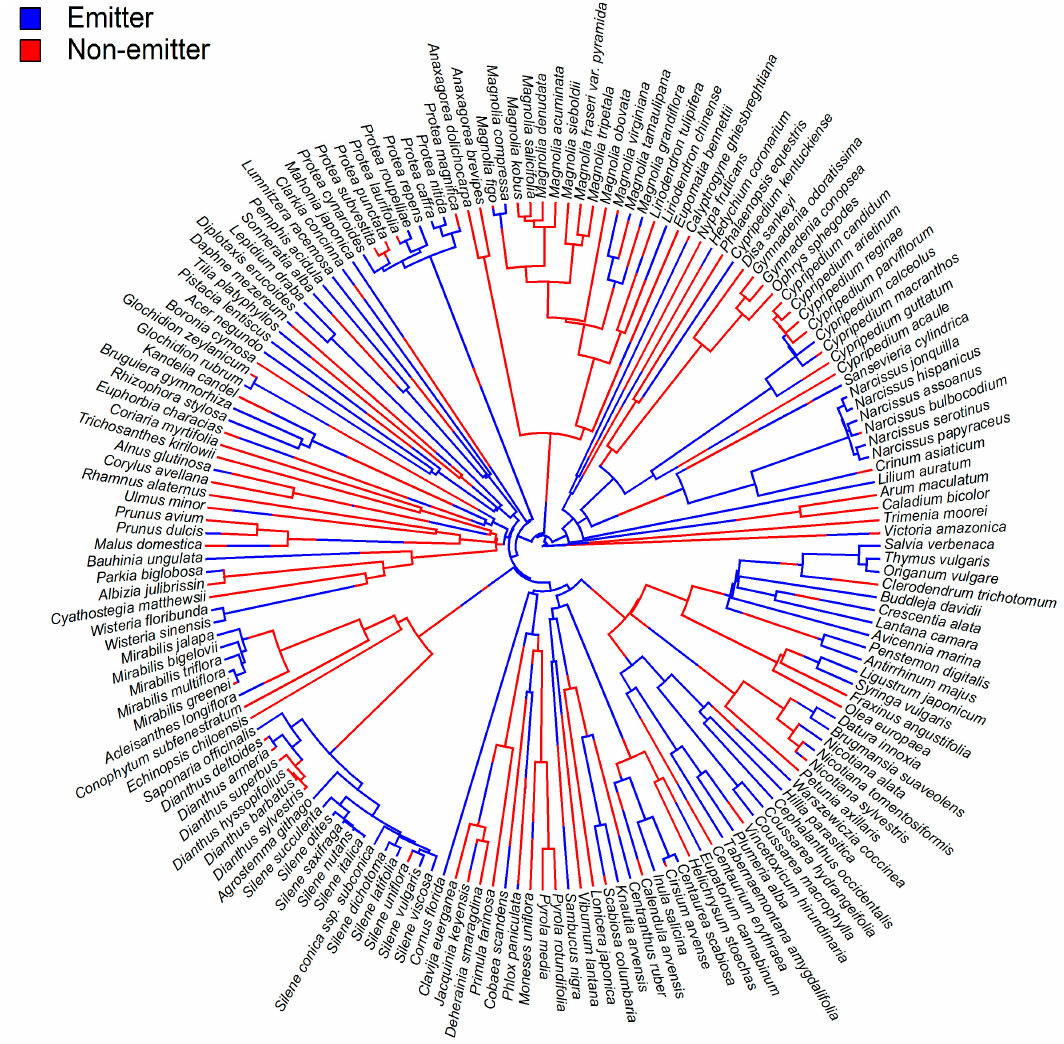
Figure 3. Ancestral phylogenetic reconstruction of floral emissions of trans - β -ocimene. One thousand trees were simulated with a mapped discrete character with states “Emitter” and “Non-emitter”. Trees had an average of 231.716 changes between states. The changes were: 117.436 Emitter → Non-emitter and 114.28 Non-emitter → Emitter. Mean times spent in each state were: 50.47% Emitter and 49.53% Non-emitter.